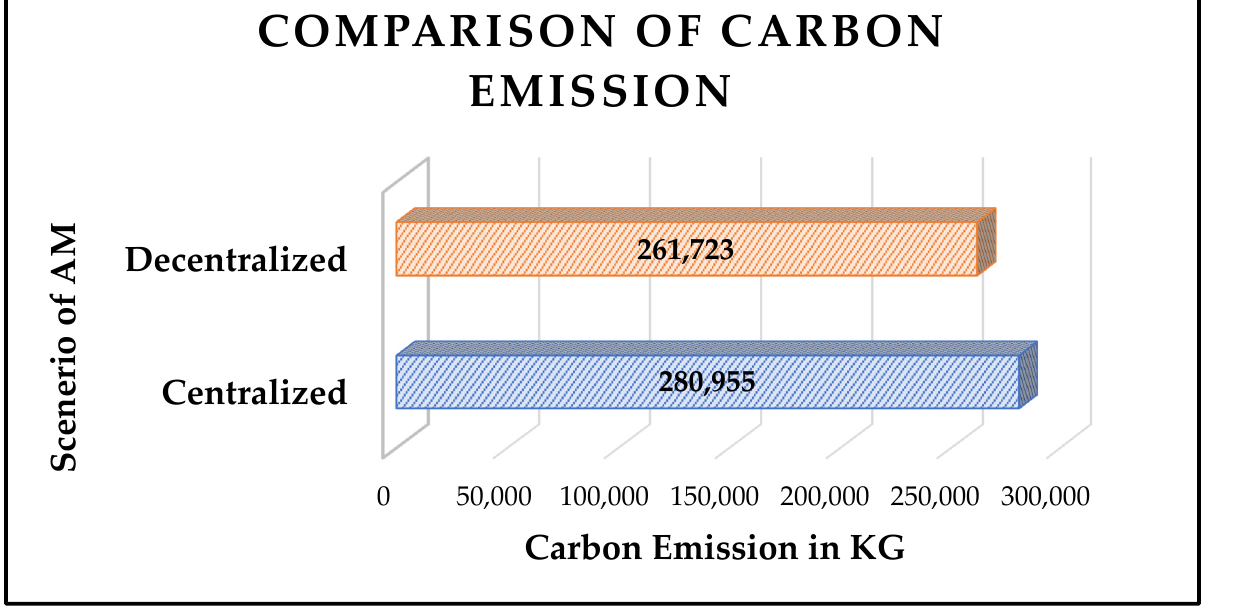
Figure 7. Comparison of Carbon Emission between Centralized and Decentralized Additive Manu- facturing [27].